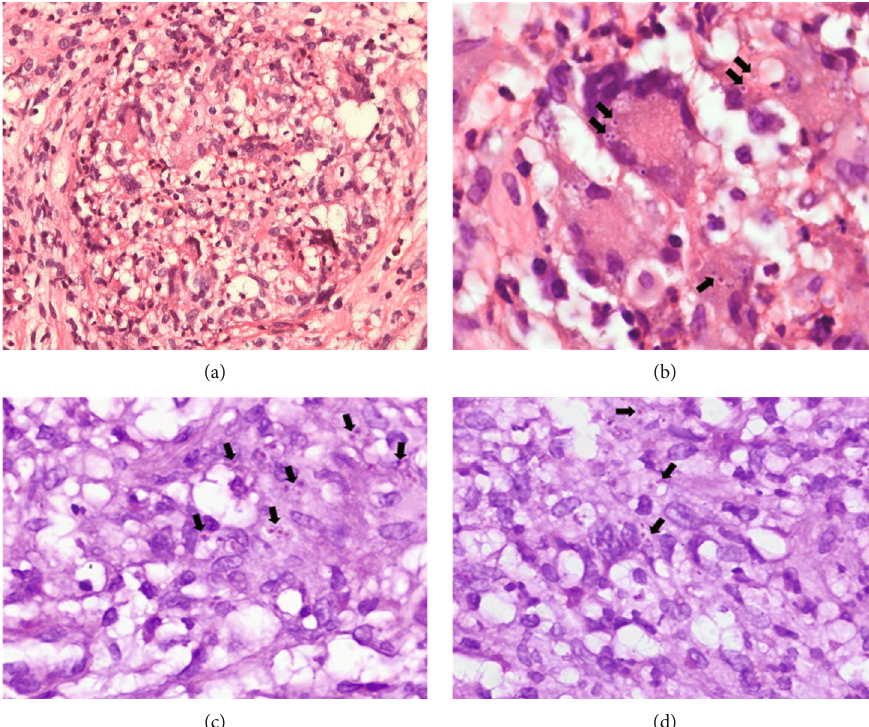
Figure 2: Connective tissue with intense in fl ammatory in fi ltrate with a granulomatous pattern, consisting of giant multinucleated in fl ammatory cells and vacuolated macrophages, with several fungi suggestive of H. capsulatum — (hematoxylin-eosin stain; (a) × 200, (b) × 400). In (c) and (d), the periodic acid-Schi ff (PAS) staining showed vacuolated macrophage with positivity for H. capsulatum ((c d) × 400). Note the numerous small rosy dots